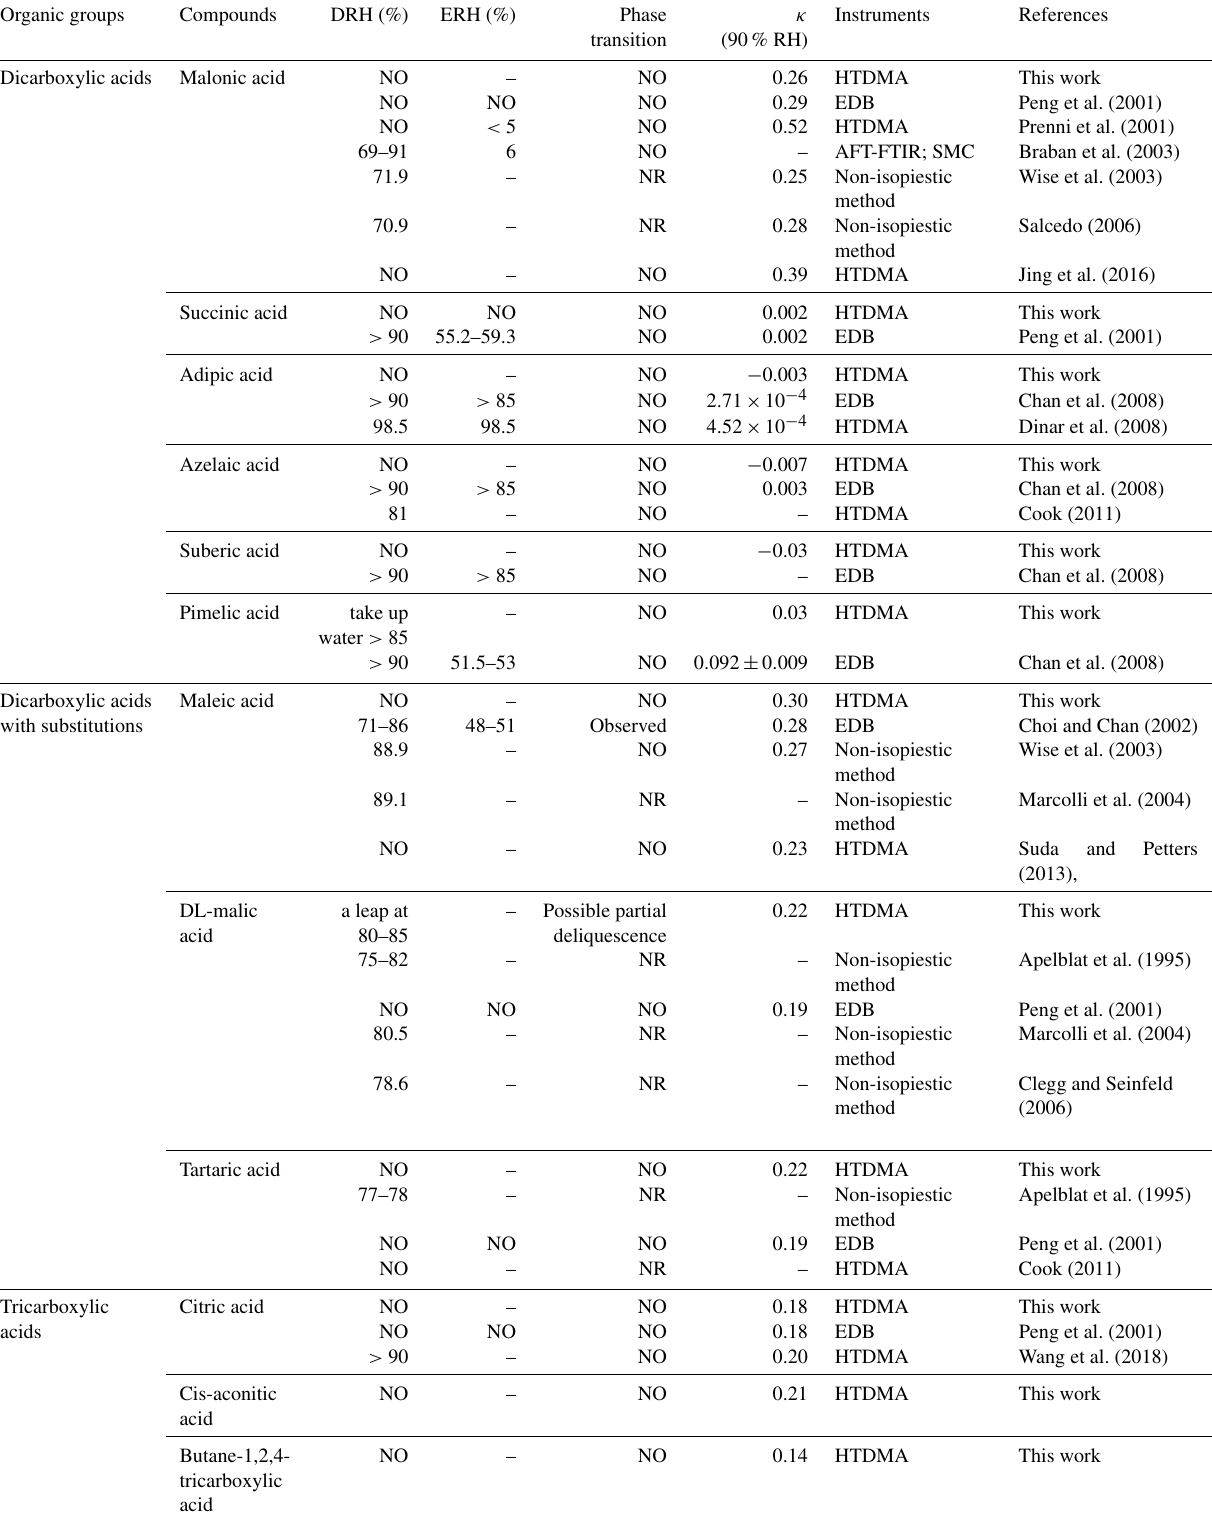
Table 2. Summary of the measured properties with respect to their DRH, ERH, phase transition, and hygroscopicity parameter (90% RH) obtained in this work and previous